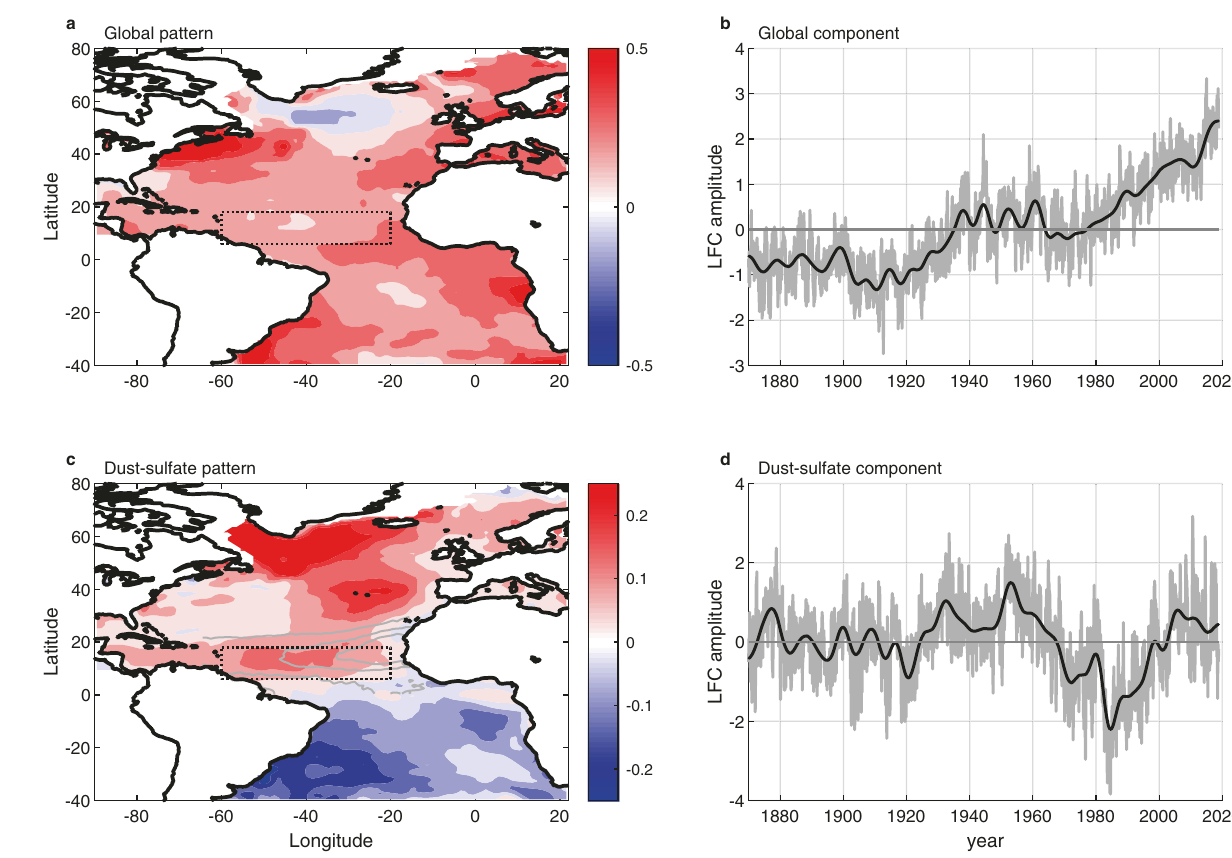
Fig. 4 | Low-frequency component analysis global and multidecadal modes of sea-surface temperature (SST) variations. Patterns of sea-surface temperature (color shading) associated with the global mode ( a ) and the dust-sulfate mode ( c ). Thedust-sulfatepatternisplottedalongwithdustaerosolopticaldepthcontours 22